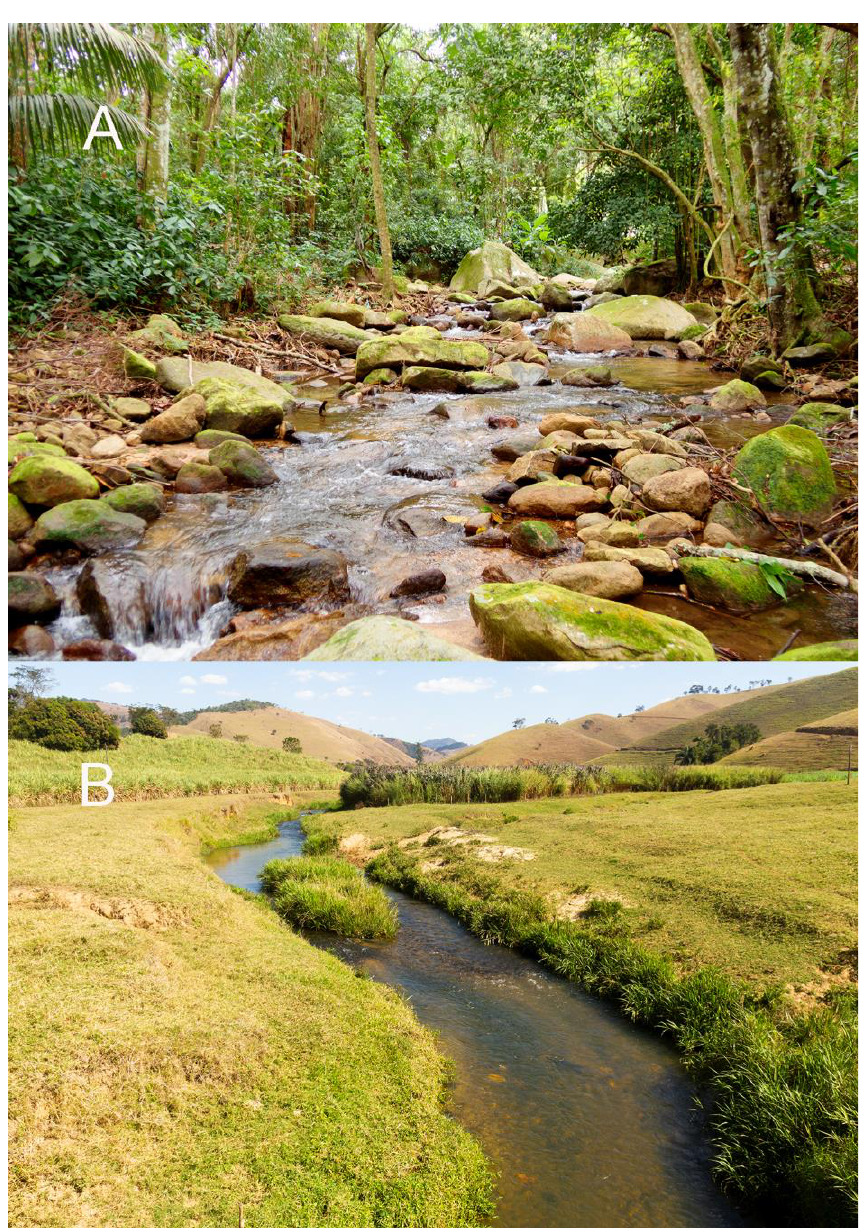
Figure 15. Type localities of ( A ) Trichomycterus saquarema Costa, Katz, Vilardo and Amorim, sp. nov.; ( B ) Trichomycterus altipombensis Costa, Katz, Vilardo and Mattos, sp. nov.